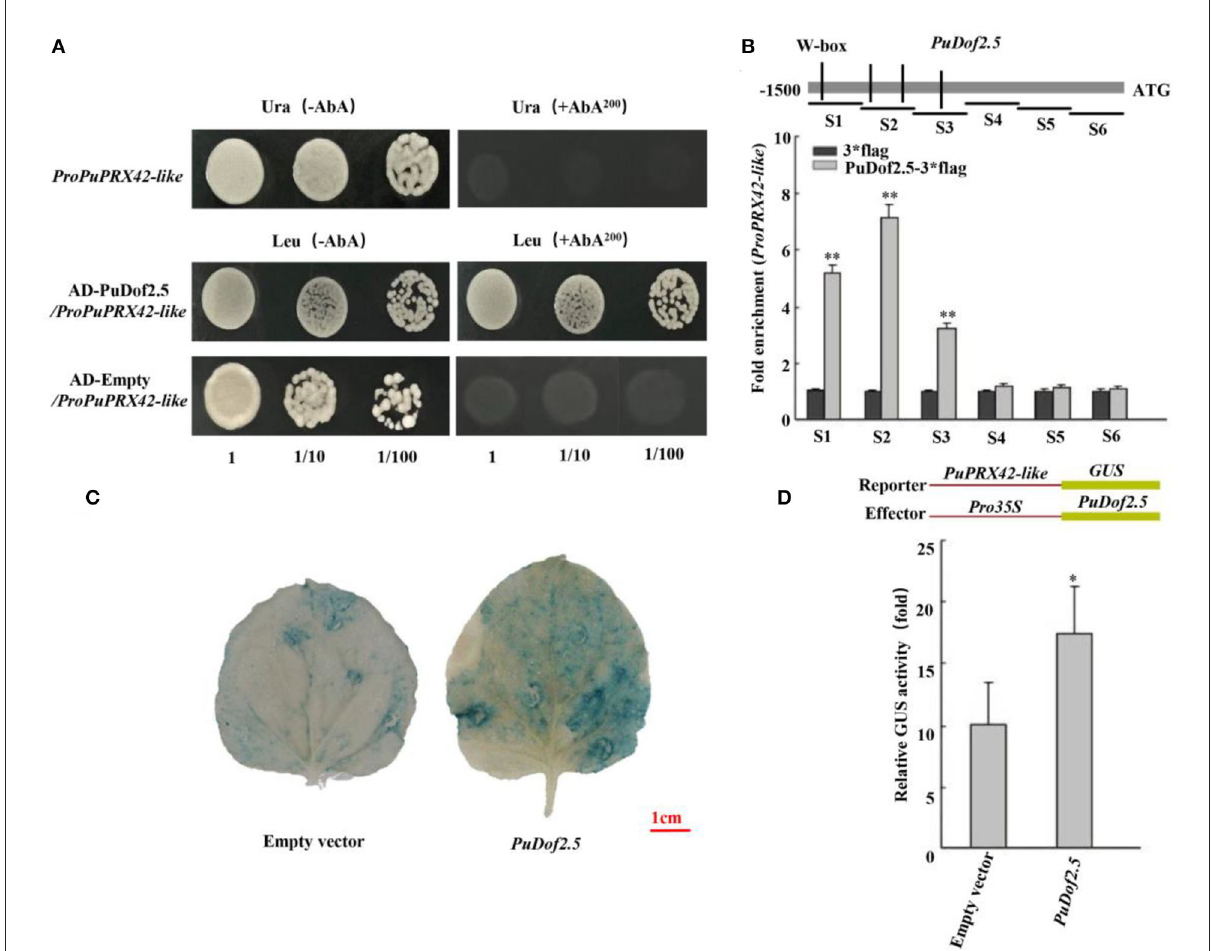
FIGURE6 PuDof2.5 regulates PuPRX42-like transcription by promoter binding. (A) Y1H analysis of PuDof2.5 binding to the promoter of PuPRX42-like . AbA is a yeast growth inhibitor, and the basal concentration was 200ng/ml. The empty vector and the PuPRX42-like promoter were used as negative controls. (B) ChIP-qPCR analysis to determine how PuDof2.5 directly binds to the PuPRX42-like promoter. Eluted DNA was used in the quantitative PCR (qPCR) performed to analyze the six fragments (S1–S6). Immunoprecipitate from cells transiently expressing the vector alone was used as a negative control. (C) Histochemical GUS ( β -glucosidase) staining. (D) GUS activity analysis to determine how PuDof2.5 promotes the activity of the PuPRX42-like promoter. Data are shown as mean ± SE (n = 3). Statistical significance was determined by Student’s t -test: * P < 0.05, ** P <